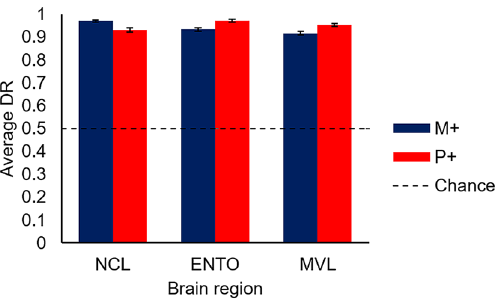
Figure 3. Behavioural performance. Overall behavioural performance on the S+/S− discrimination, as indicated by the discrimination ratio (DR). The dashed line denotes chance performance (0.5), and error bars are ±1 SEM. M+, Monet S+; P+, Picasso